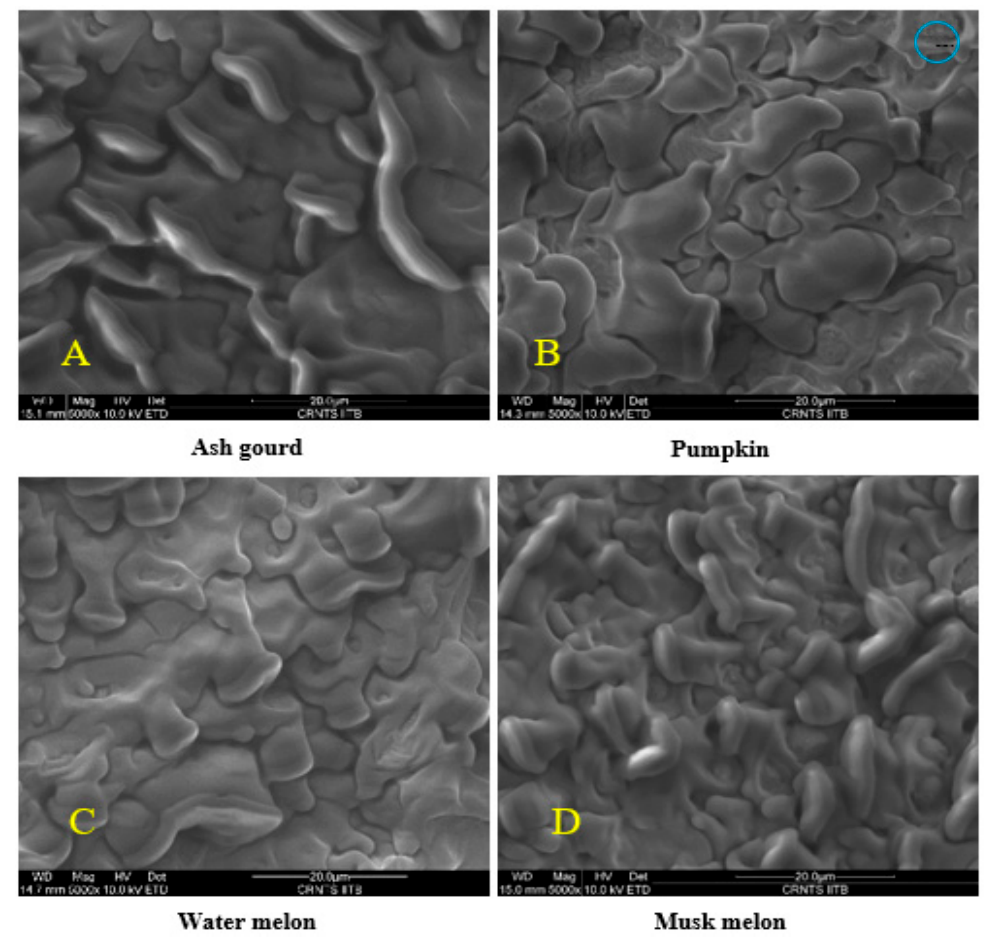
Figure 5. Microstructure (SEM) of seeds: ( A ) ash gourd, ( B ) pumpkin, ( C ) watermelon, ( D ) and musk melon at 5000 ×